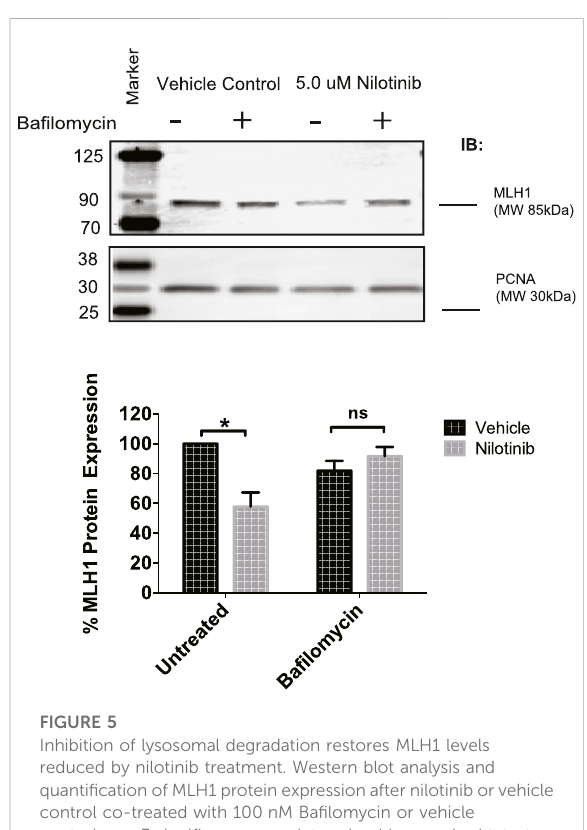
FIGURE 5 Inhibition of lysosomal degradation restores MLH1 levels reduced by nilotinib treatment. Western blot analysis and quanti fi cation of MLH1 protein expression after nilotinib or vehicle control co-treated with 100 nM Ba fi lomycin or